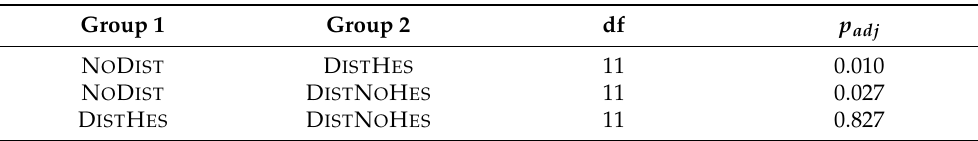
Table 3. Post-hoc pairwise comparison with Bonferroni correction of “unsuccessful” interaction between the